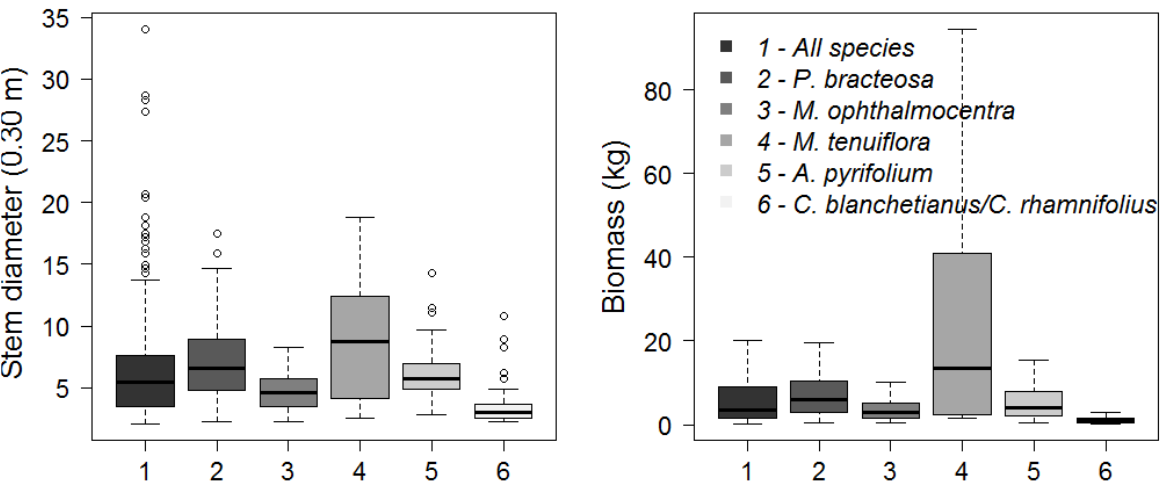
Figure 2 - Box-plot for the base diameter and the biomass above ground. The boxes represent the 25th and 75th percentiles; the dashed margins represent the 10th and 90th percentiles. The line represents the median and the points indicate the presence of discrepant data